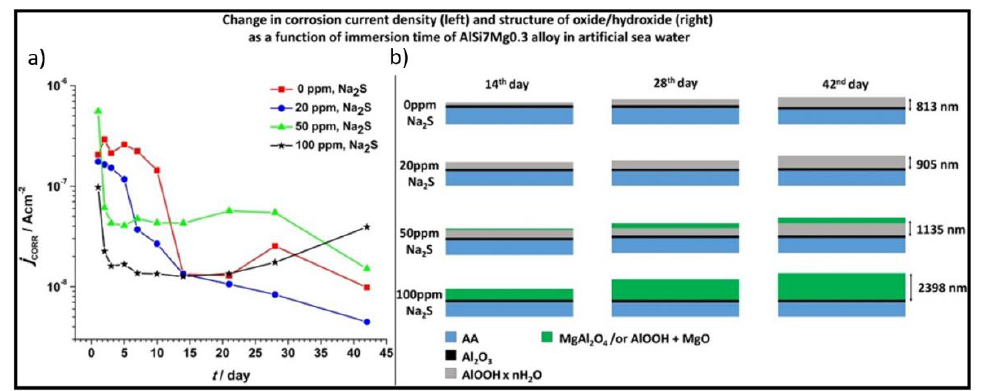
Figure 4. ( a ) Change in corrosion density as a function of immersion time. ( b ) Schematic presentation of oxide layer formation at the surface of AA EN-AlSi7Mg0.3 during the course of immersion in artificial sea water with added Na 2 S. Reprinted with permission of [7].